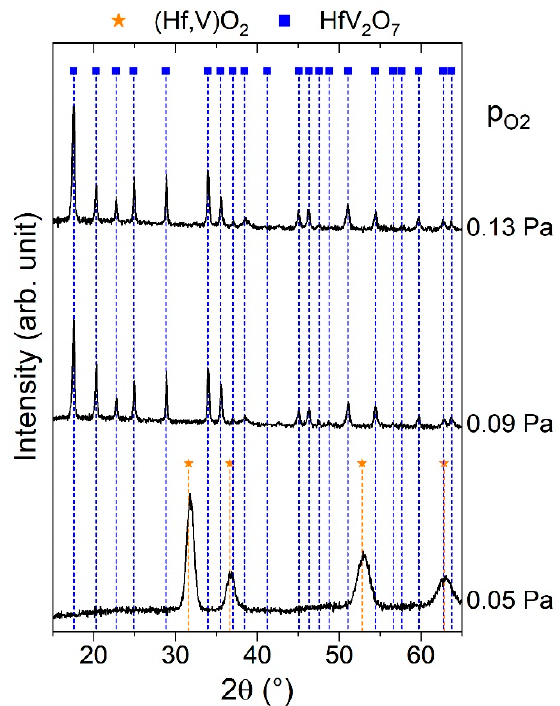
Figure 6. X-ray di ff ractograms of reactively sputtered Hf-V–O (V / Hf = 2) thin films deposited at 450 ◦ C Figure 6 . X-ray diffractograms of reactively sputtered Hf–V–O (V/Hf = 2) thin films deposited at 450 with varying O 2 partial °C with varying O 2 partial pressure.